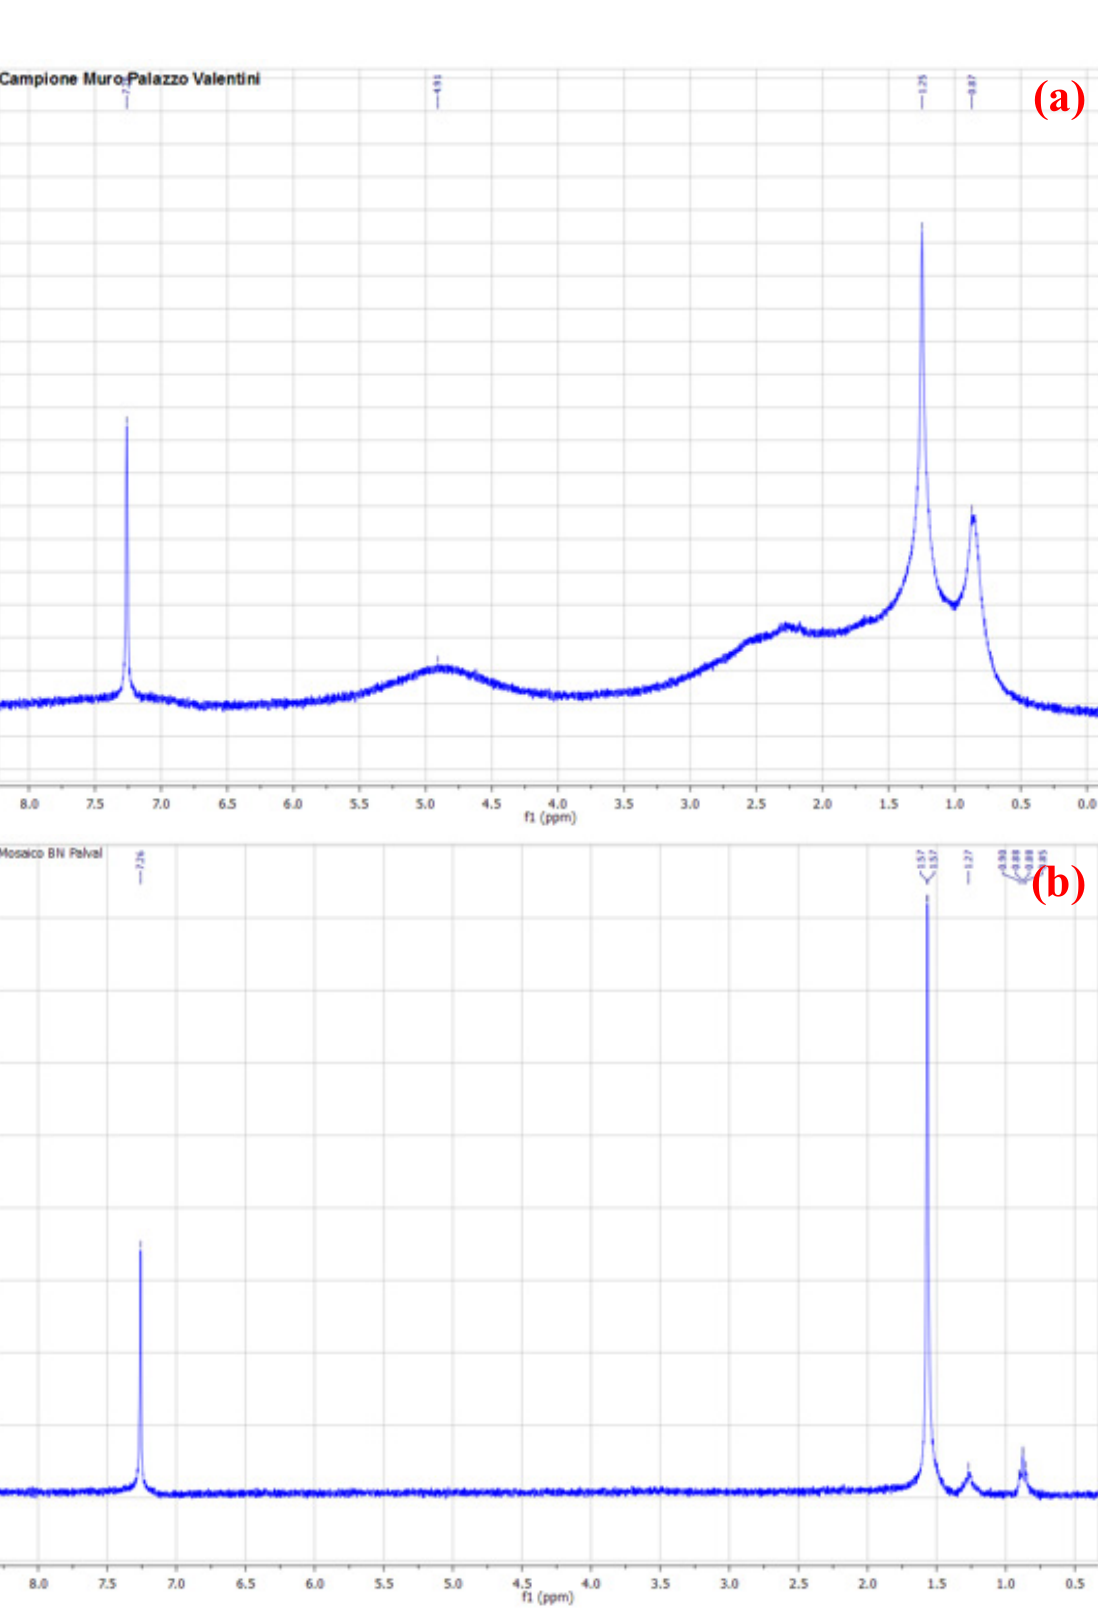
3 ) of ( a ) wall and ( b ) pavement